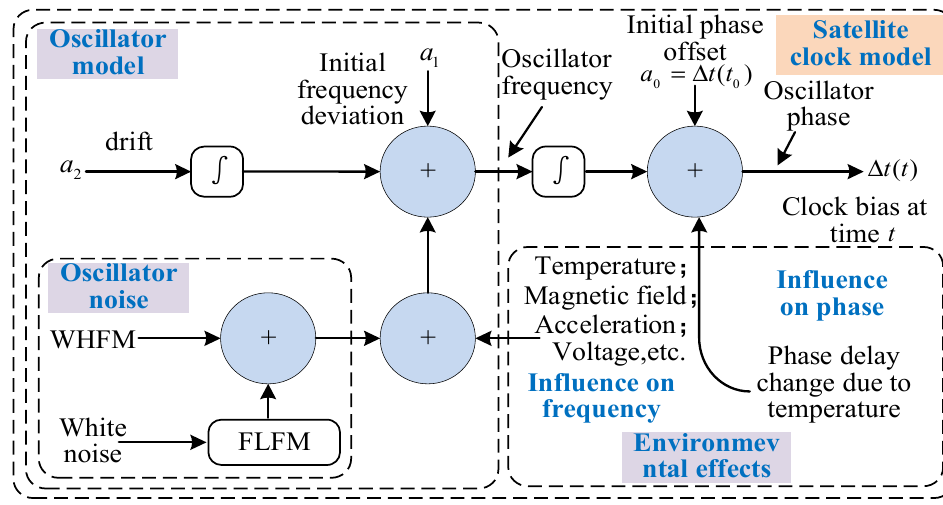
Figure 4. Satellite clock systematics model, including environmental and random effects.